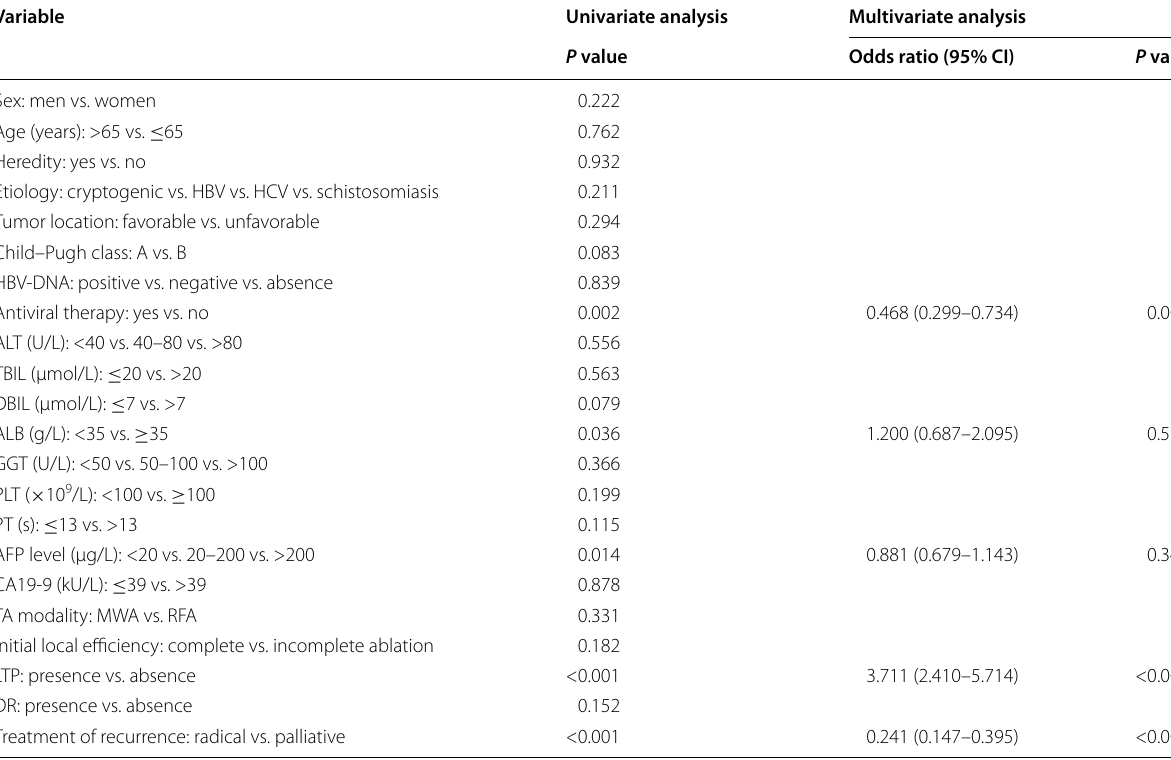
Table 4 Univariate and multivariate analyses of prognostic factors for overall